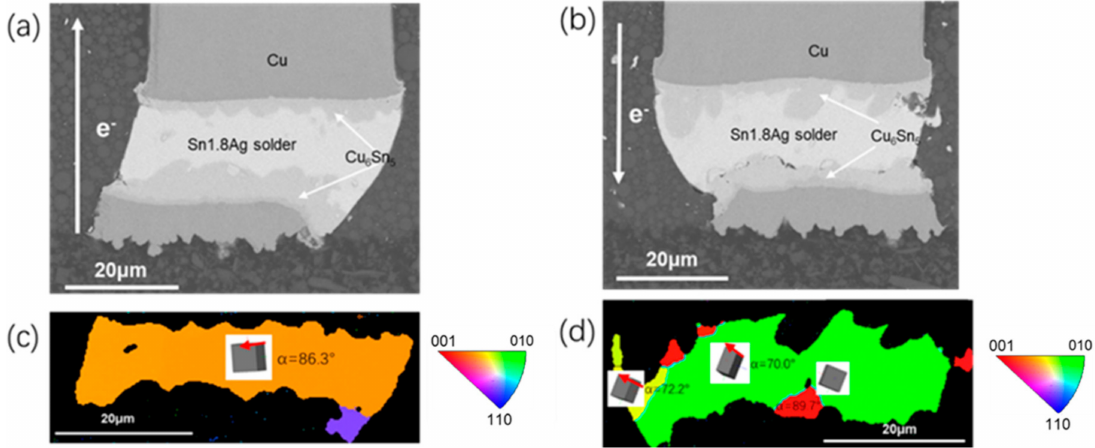
Figure 4. Microstructure after current stressing at 1.5 × 10 4 A/cm 2 at 125 ◦ C for 200 h: ( a ) SEM image for the copper pillar with upward current flow; ( b ) SEM image for the copper pillar with downward current flow; ( c ) the EBSD image corresponding to ( a ); ( d ) the EBSD image corresponding to ( b